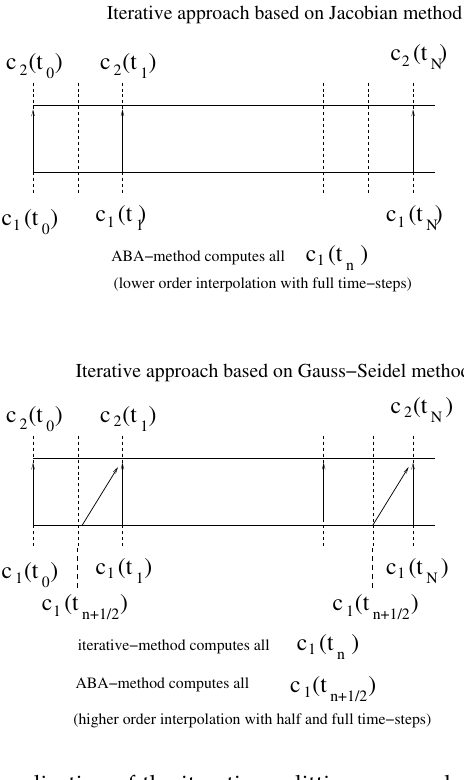
Figure 1. Function and visualisation of the iterative splitting approach for i = 2: In the upper figure, we apply an iterative splitting approach based on the Jacobian-method. Here, we apply for the initialisation of the c 1 -values for the full time-steps ∆ t an ABA-method. Therefore, we obtain a lower order interpolation for the itertative approaches of the c 2 -values. In the lower figure, we apply an iterative splitting approach based on the Gauss-Seidel-method. Here, we apply for the initialisation of the c 1 -values for the full time-steps ∆ t an iterative method and additional for the half step ∆ t /2 an ABA-method. Therefore, we obtain a higher order interpolation for the iterative approaches of the c 2 -values. We improve the starting conditions for the iterative splitting approach with i = 2 and obtain higher order